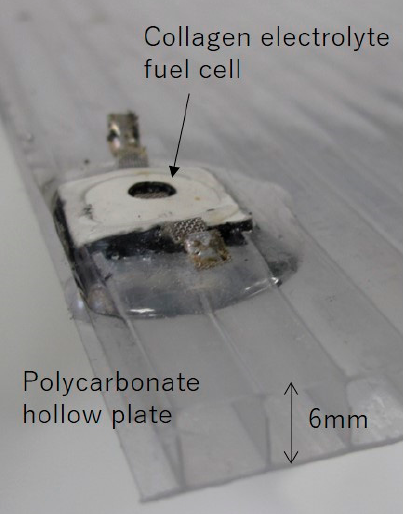
Figure 3. Shape of the photosynthetic panel.